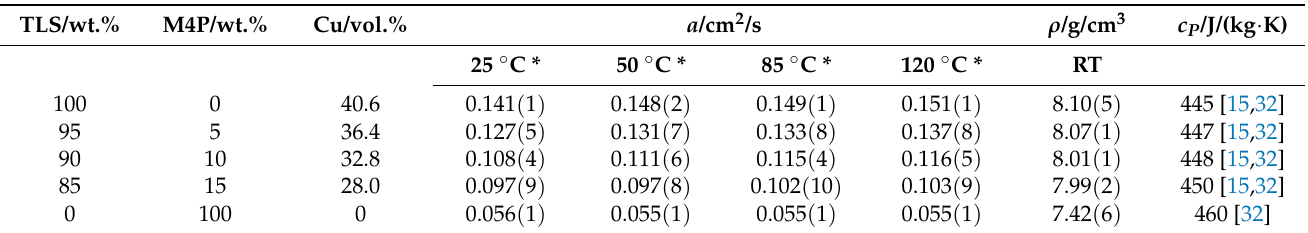
Table 3. Thermal diffusivity 𝑎 , material density 𝜌 and specific heat capacity 𝑐 𝑃 for the H11/Cu composite materials and the sintered H11 tool steel.